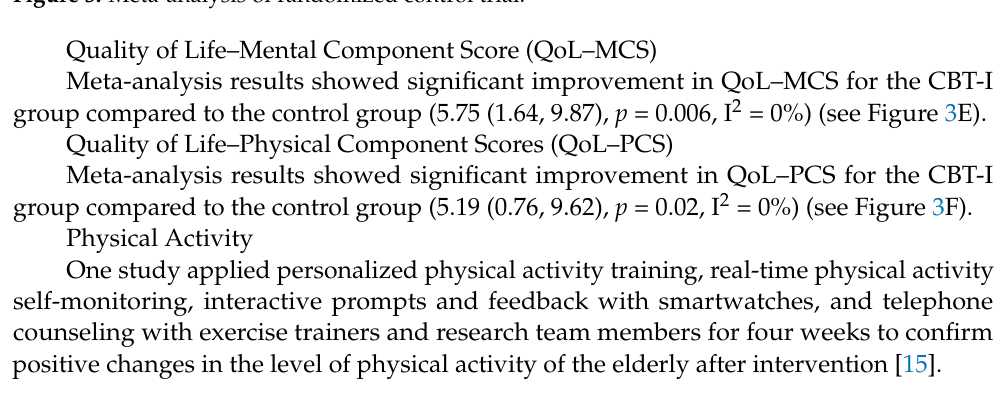
Figure 3. Meta-analysis of randomized control trial.